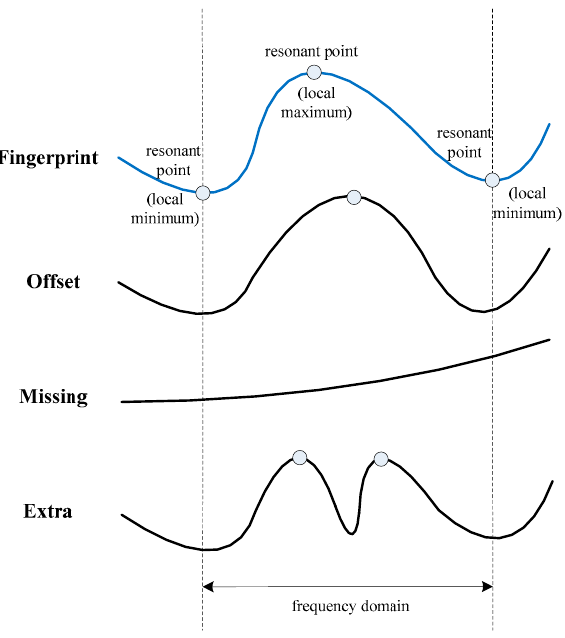
Figure 5. Three typical situations of resonant point variation.